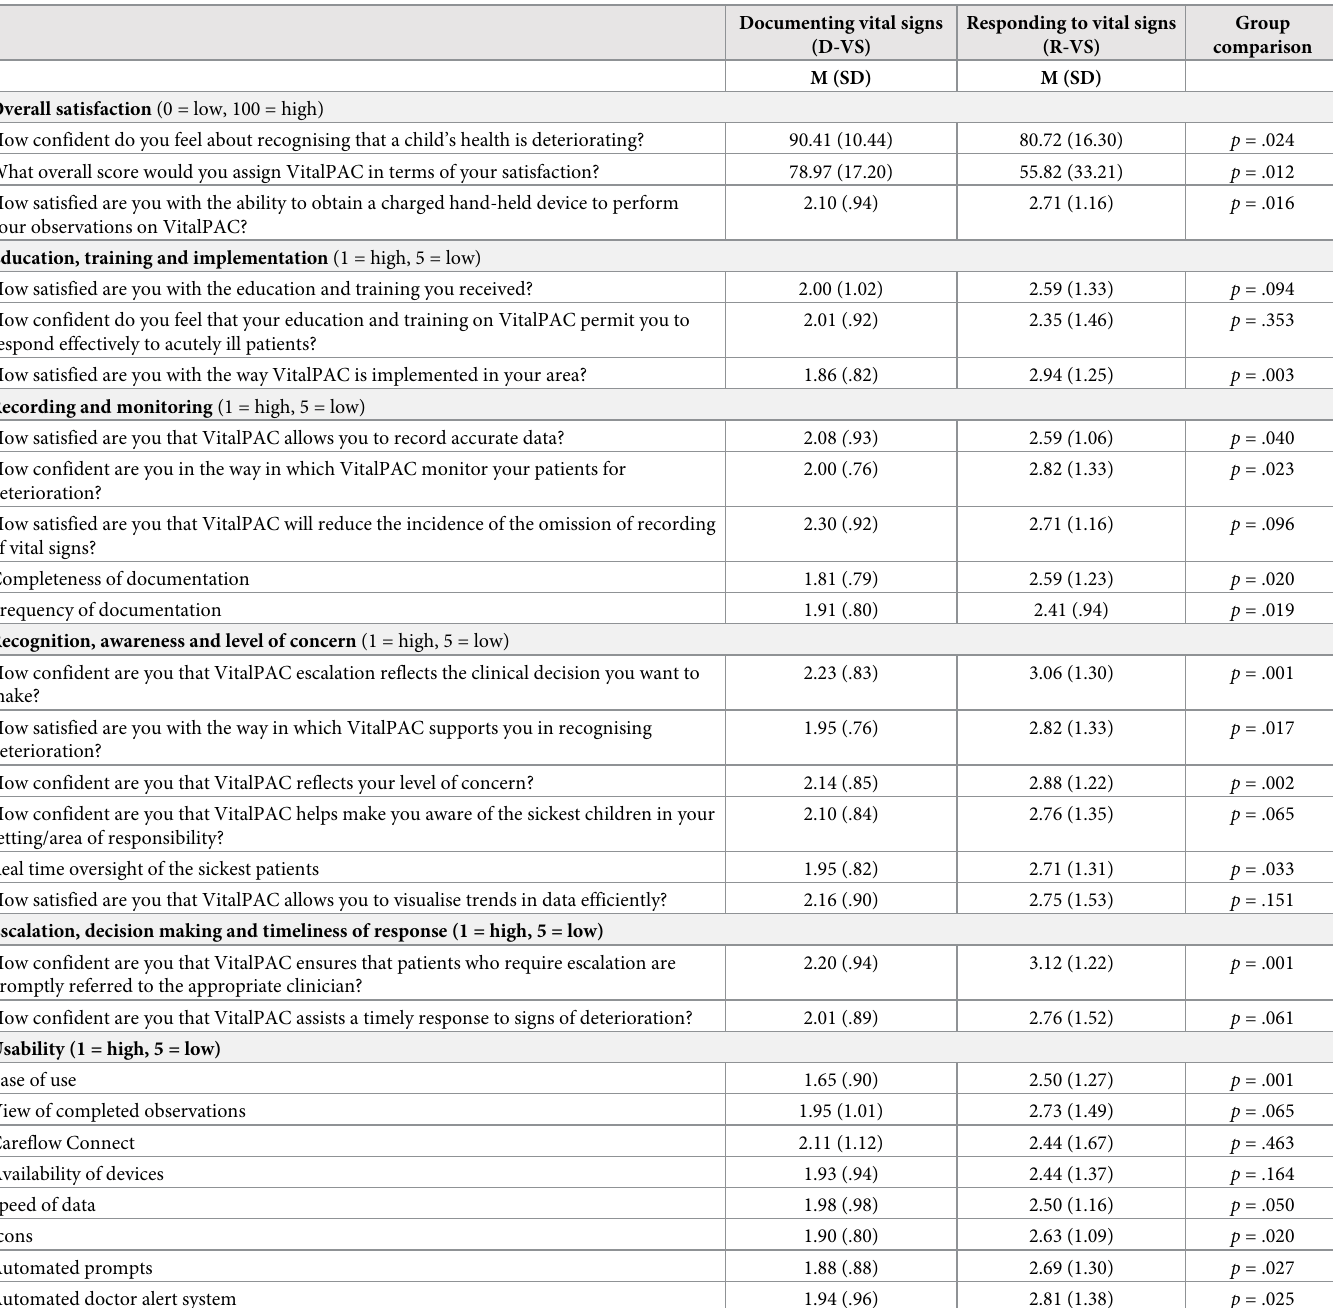
Table 5. Health professionals’ responses: Comparison between D-Vs and R-VS � .